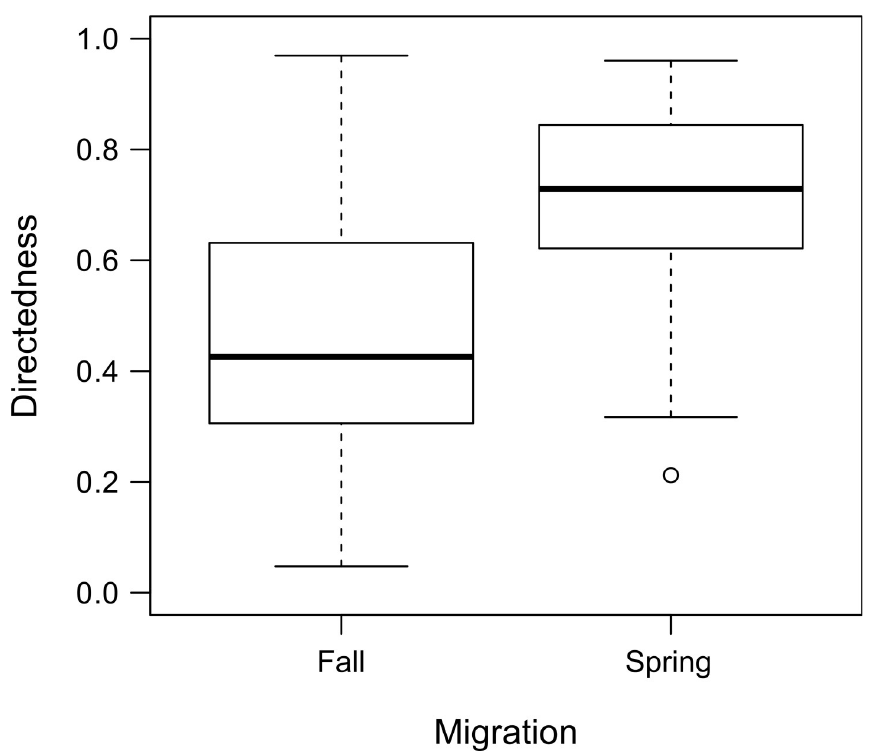
Fig 4. Directedness of fall and spring migration for the Teshekpuk Caribou Herd. Directedness indicates the degree of tortuosity of a caribou’s migration path, with lower values indicating a more tortuous migration path and higher values indicating more directed movement. Across all migrants, spring migration tended to be more directed than fall (p < 0.001).